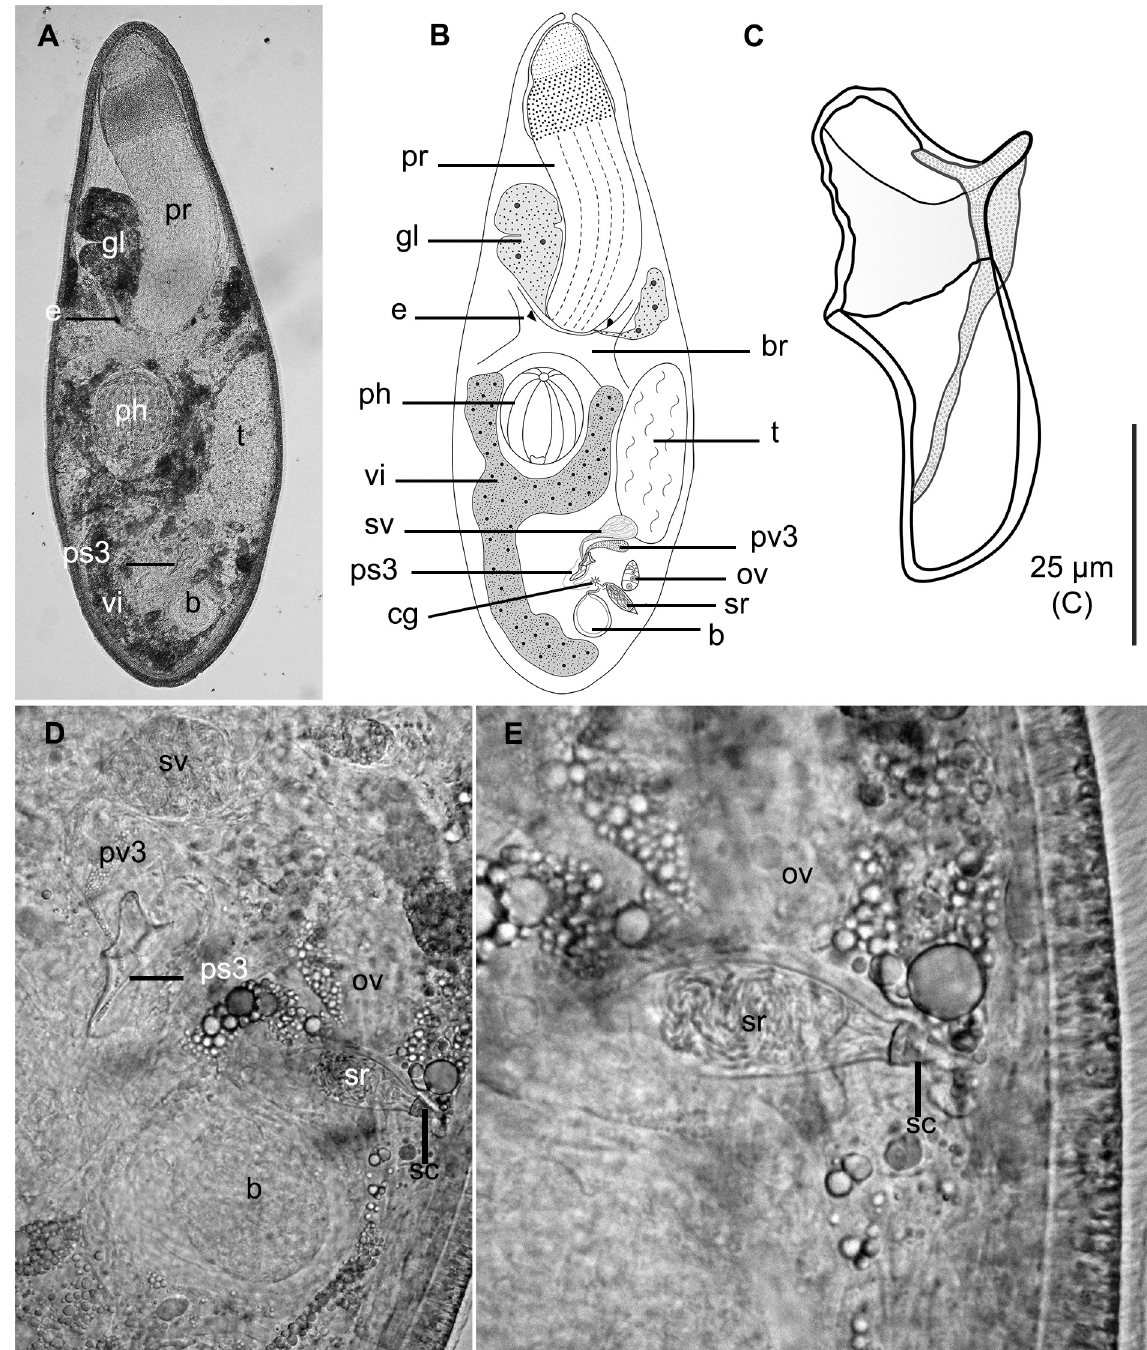
Fig. 4. Species of Typhlopolycystidinae Evdonin, 1977. Sabulirhynchus ibarrae sp. nov. A–B . Live animal. C . Holotype (FMNH), prostatic stylet type III. D–E . Details of the genital